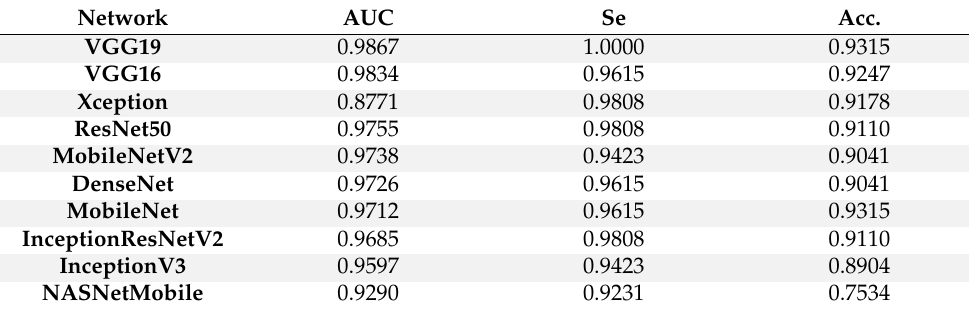
Table 4. Evaluation of different networks using the randomized test set.